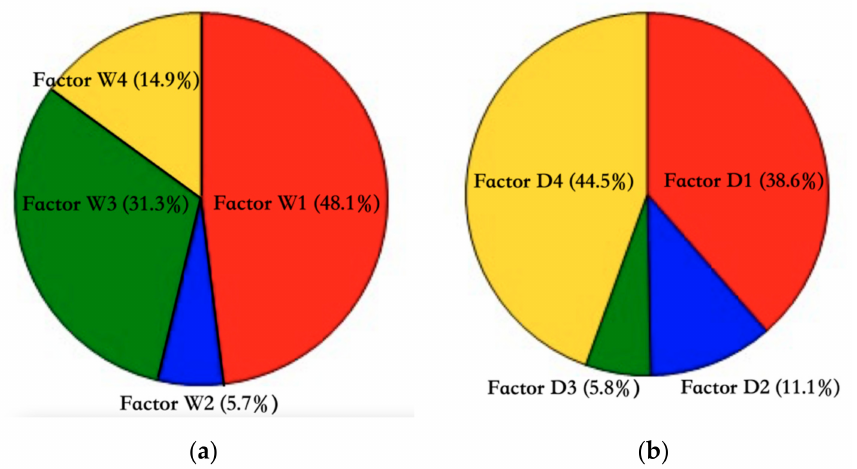
Figure 8. ( a ) Source apportionment of PM 2.5 in the wet season. Factor W1: Fossil fuel combustion and secondary inorganic particles; Factor W2: Metal smelting; Factor W3: Road dust; Factor W4: Biomass combustion and sea salt; ( b ) Source apportionment of PM 2.5 in the dry season. Factor D1: Fossil fuel combustion; Factor D2: Road dust; Factor D3: Metal smelting; Factor D4: Biomass combustion and secondary inorganic particles.